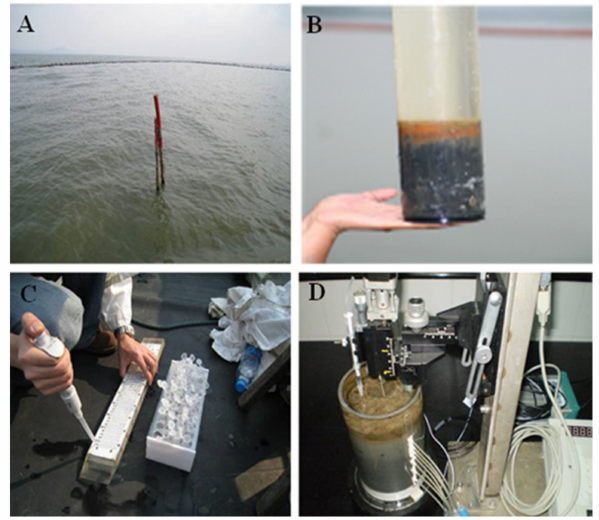
Figure 9. Sediment sampling in the open water in Shiba Bay of Lake Tai after the MLS